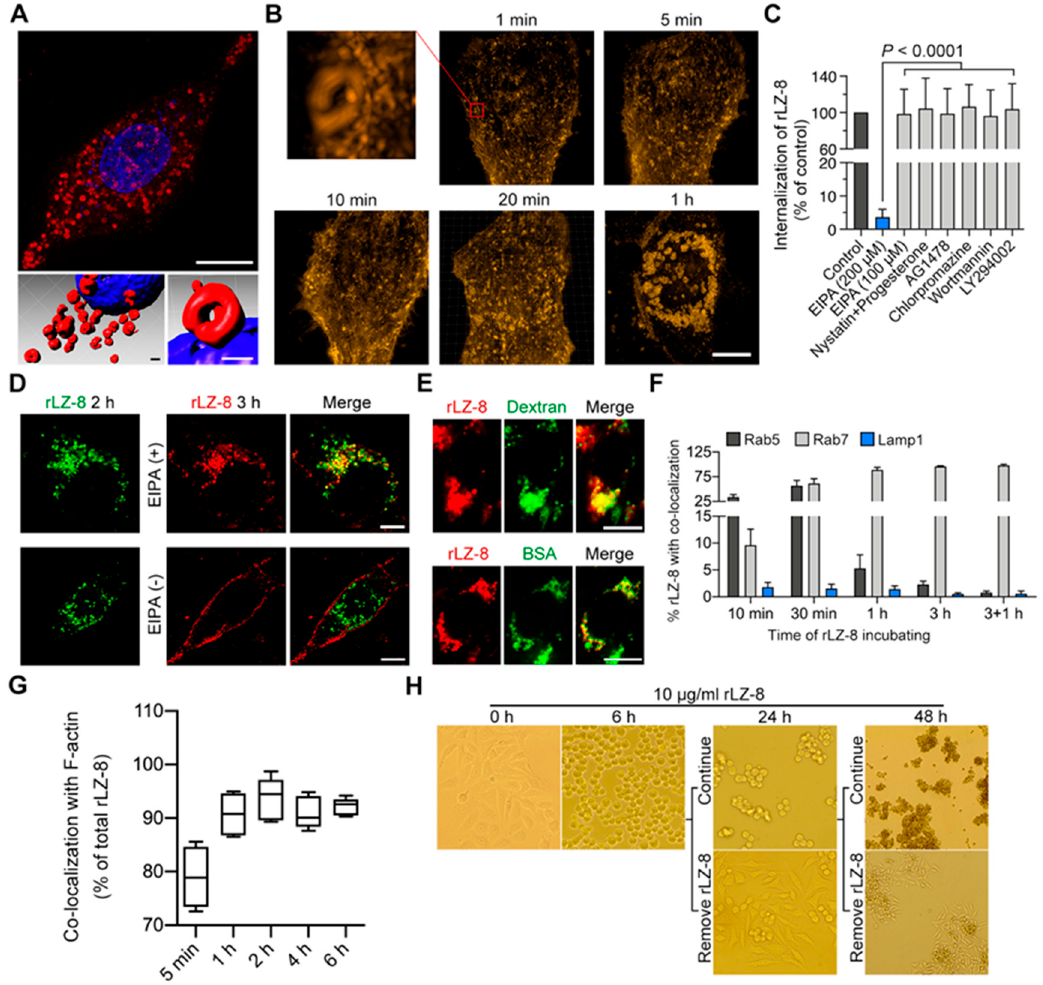
Figure 2. rLZ-8 induced intense macropinocytosis and blockage of endosomal recycling. ( A ) Ring-like vesicles appeared near the nuclei after 10 µ g / mL rLZ-8 (red) treating on Hep3B cells for 1 h by 3D-SIM imaging. Cell nuclei were dyed by Hoechst (blue). Surface rendering was generated from Imaris. Scale bars in above, 10 µ m, in below, 1 µ m. ( B ) 10 µ g / mL rLZ-8 (red) was treated on Hep3B cells for di ff erent time before cells imaging. Scale bars, 10 µ m. ( C ) 5 µ g / mL rLZ-8 treated on Hep3B cells for 2 h after di ff erent inhibitors pre-incubated for 30 min. Internalization of rLZ-8 was analyzed by Imaris. Statistical significance was calculated with a nonparametric Kruskal-Wallis test, in which a p < 0.0001 was considered significant. ( D ) 5 µ g / mL rLZ-8 (green) treated on Hep3B cells for 2 h, then be removed. Same dose rLZ-8 (red) added after EIPA (200 µ M) pre-incubated for 30 min. Cells were imaged 2 h later. Scale bars, 10 µ m. ( E ) 10 µ g / mL rLZ-8 (red) and 100 µ g / mL Dextran or BSA (green) co-treated on Hep3B cells for 1 h before cells imaging. Scale bars, 10 µ m. ( F ) Immunofluorescent staining of Rab5, Rab7 or LAMP1 after 10 µ g / mL rLZ-8 treated for di ff erent time. For 3 + 1 h group, rLZ-8 was removed after treatment for 3 h and cells incubation lasted 1 h. The co-localization with rLZ-8 was analyzed by Imaris software. ( G ) Immunofluorescent staining of F-actin after 10 µ g / mL rLZ-8 treated on Hep3B cells. Co-localization was analyzed by Imaris. ( H ) Live imaging of Hep3B cells using phase contrast microscopy. Three groups of cells were exposed to 10 µ g / mL rLZ-8. In 2 groups, rLZ-8 treatment was discontinued after 6 h or 24 h of exposure. Magnification × 200 for 0 h, 6 h and 24 h imaging and × 40 for 48 h imaging. All data are means ± SD.